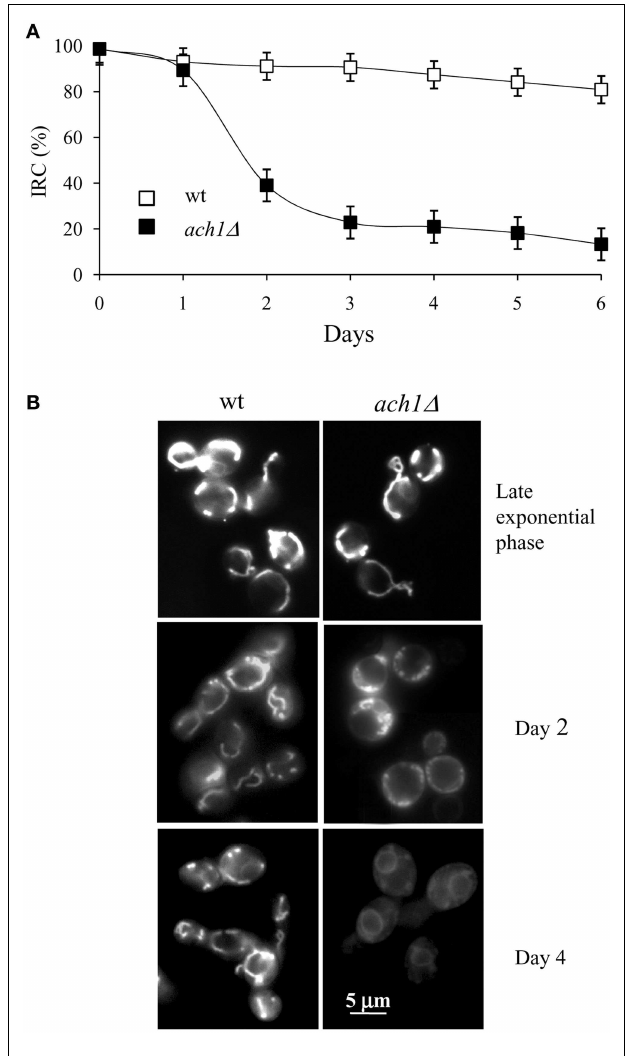
FIGURE 3 | Chronological aging ach1 ∆ cells display compromised mitochondrial activity. Chronological aging cultures of Figure 1 at the indicated time-points were serially diluted, plated ontoYEPD andYEPG plates and the index of respiratory competence (IRC) was determined (A) . Standard deviations of three independent experiments are indicated. (B) Same cells stained with DiOC 6 to visualize mitochondrial membranes. Morphologies of the mitochondria of cells in late exponential phase are also reported. Representative images are shown. Bar: 5 µ